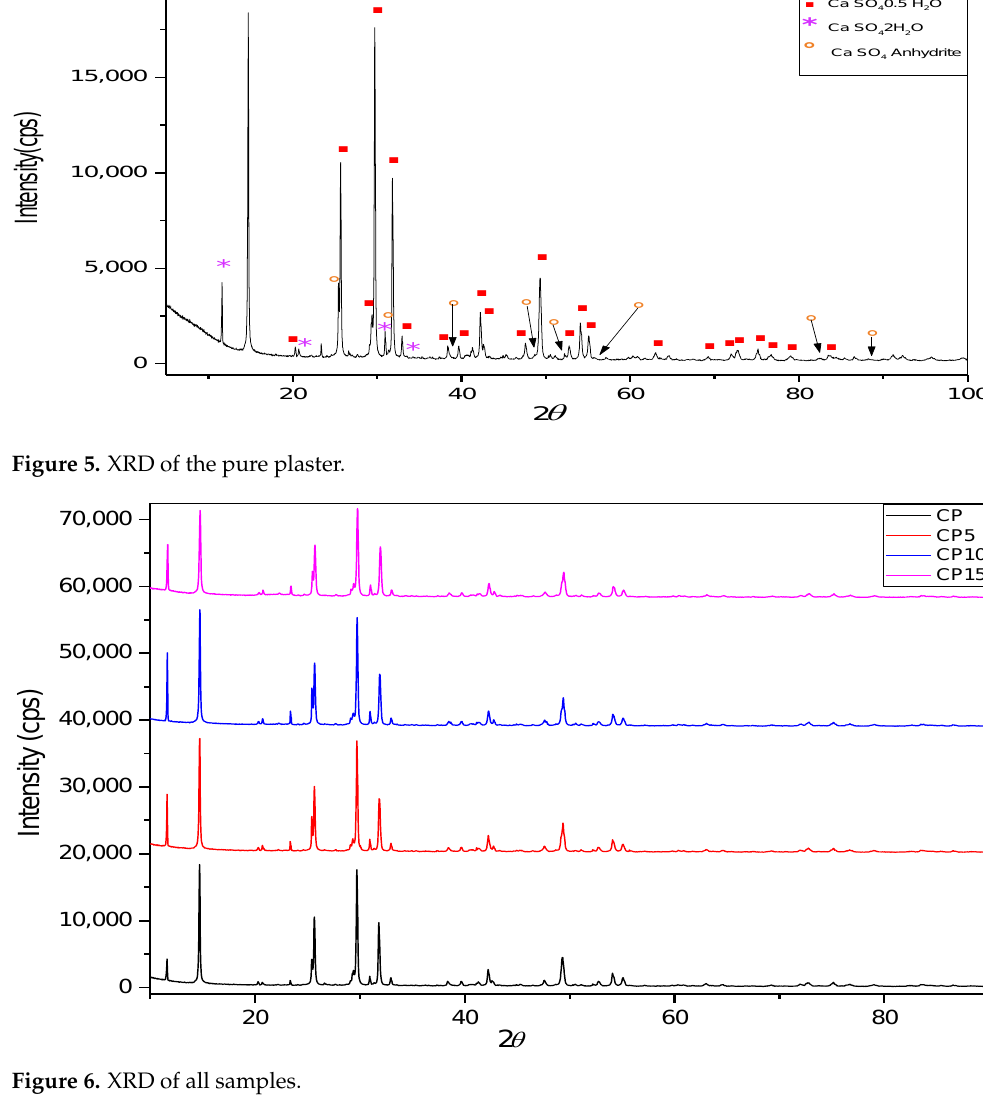
Figure 6. XRD of all